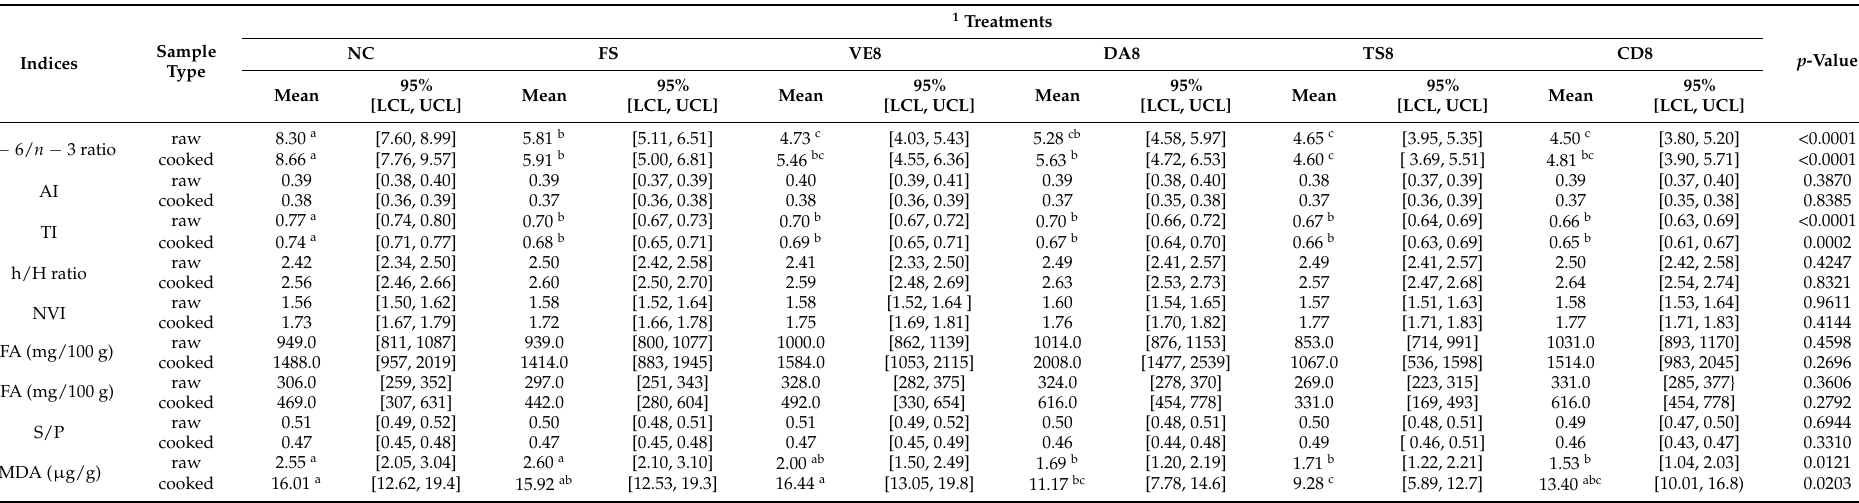
Table 5. Effect of supplementing plant polyphenol extracts and flaxseed on lipid health indices and oxidative stability in raw and cooked breast meat of Sasso